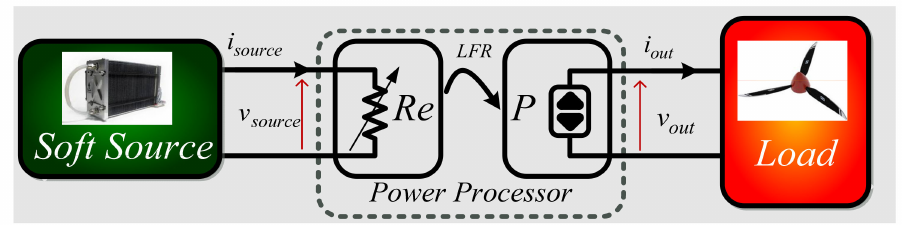
Figure 3. LFR-based representation of a power